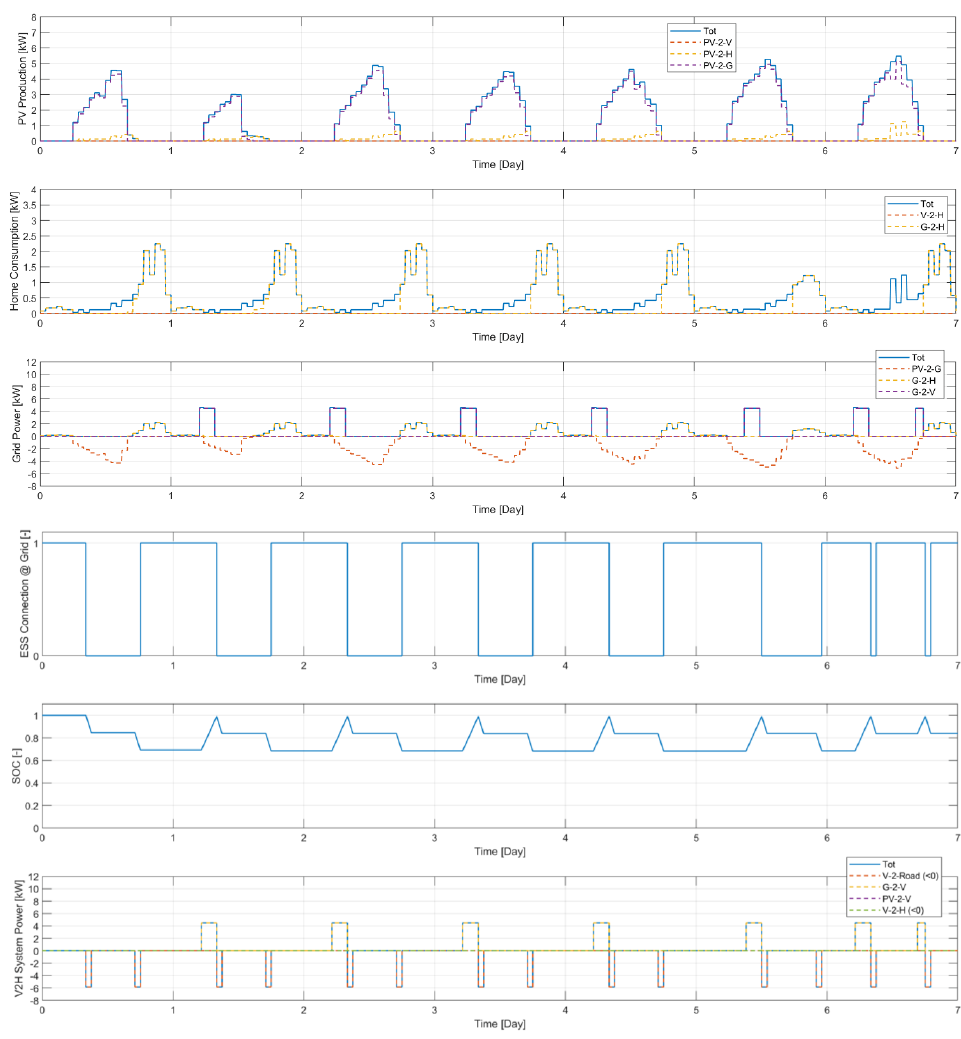
Figure 10. Summer week. Base Case results.